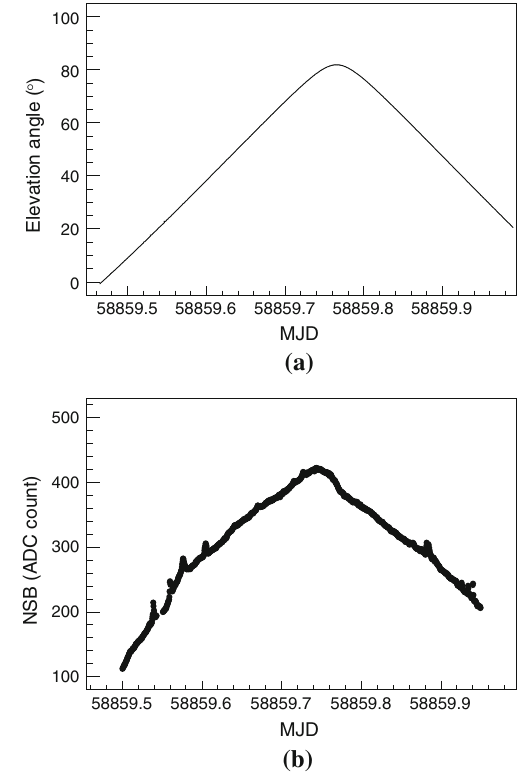
Fig. 21 a The elevation angle of the moon as a function of time. b The NSB measured by one pixel is modulated by the moonlight. Because of atmospheric scattering and absorption, the amount of moonlight col- lected by the telescope is a function of the moonlight slant depth in the atmosphere and the scattering angle which is the space angle between the direct moonlight and the telescope. Some small peaks caused